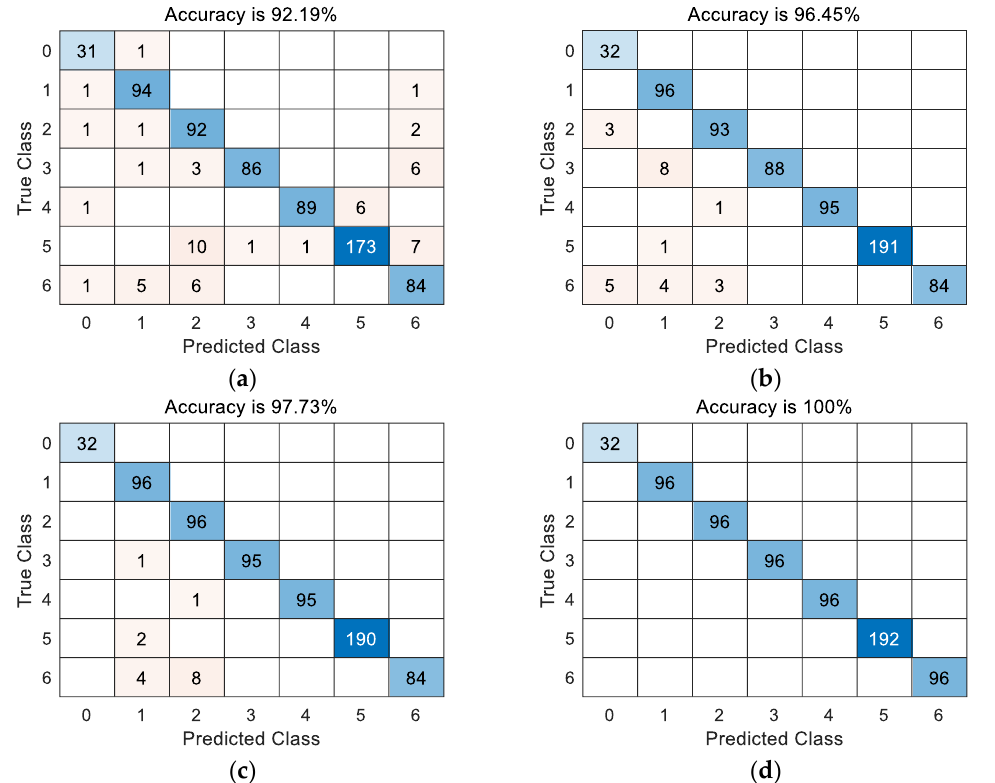
Figure 13. Confusion matrix of fault classification results of different algorithms ( a ) BiLSTM; ( b ) CNN; ( c ) CNN-BiLSTM; ( d ) Res-BiLSTM.